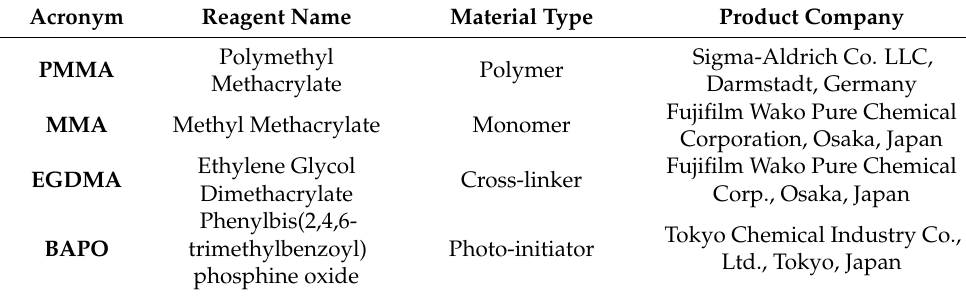
Table 1. Reagents used for preparation of the PMMA-based resins.